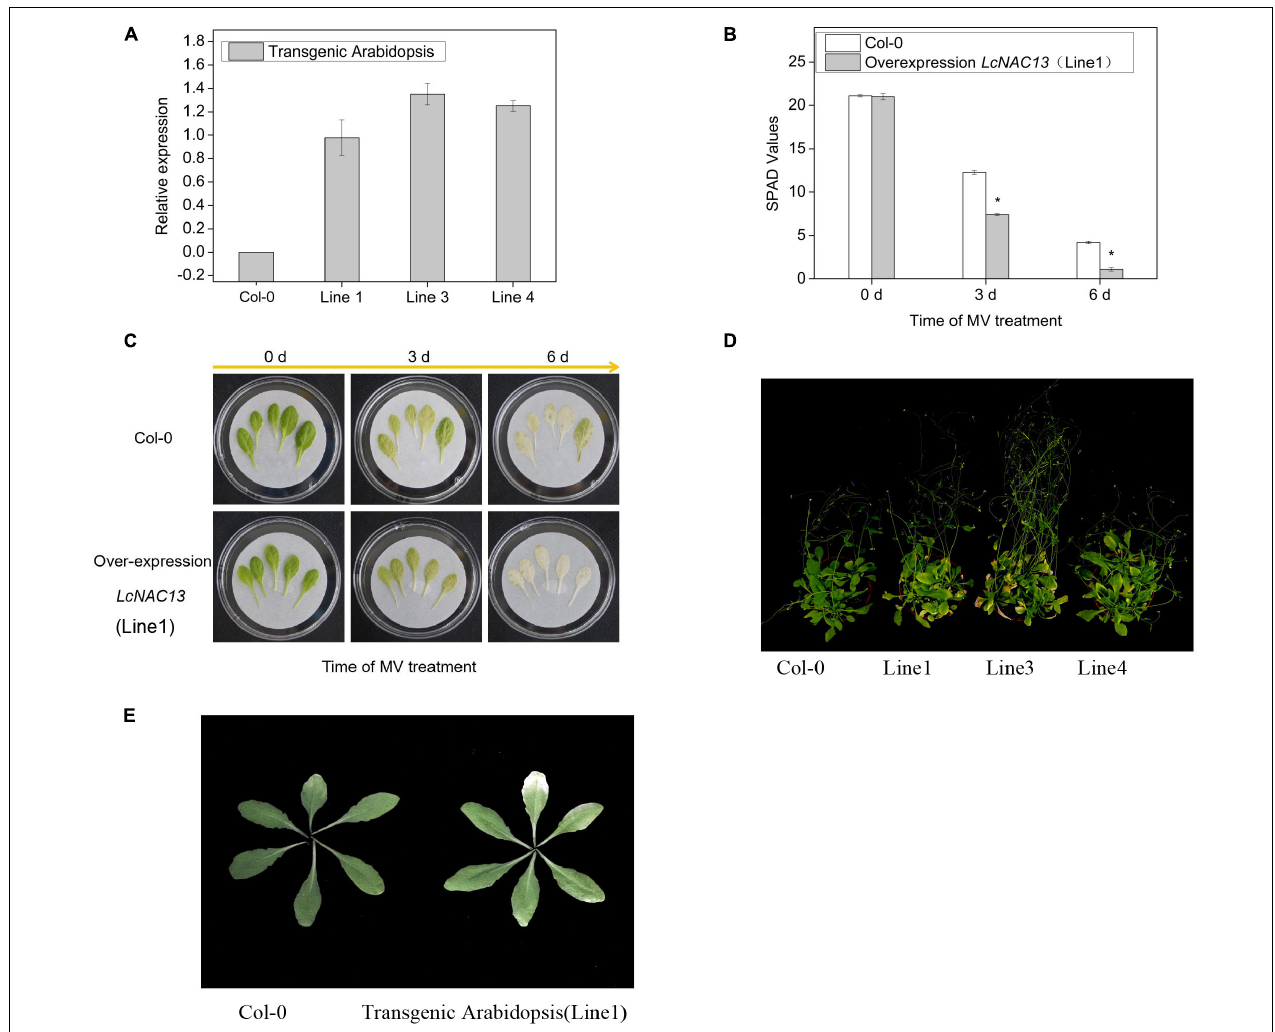
FIGURE 5 | Overexpression of LcNAC13 promotes ROS-dependent and nature senescence in Arabidopsis thaliana. (A) Relative expression of LcNAC13 in the three transgenic lines. (B) SPAD values in leaves of the transgenic and wild-type plants after methyl viologen dichloride hydrate (MV) treatment. (C) Phenotypic changes in leaves of the transgenic and the wild-type plants after MV treatment. (D) Phenotype of the transgenic and the wild-type plants showing natural senescence. (E) Rosette leaves of the transgenic and wild-type plants 32 days after planting. Vertical bars represent SE ( n = 3); an asterisk indicates a significant difference according to Student’s t -test ( P ≤ 0.05).